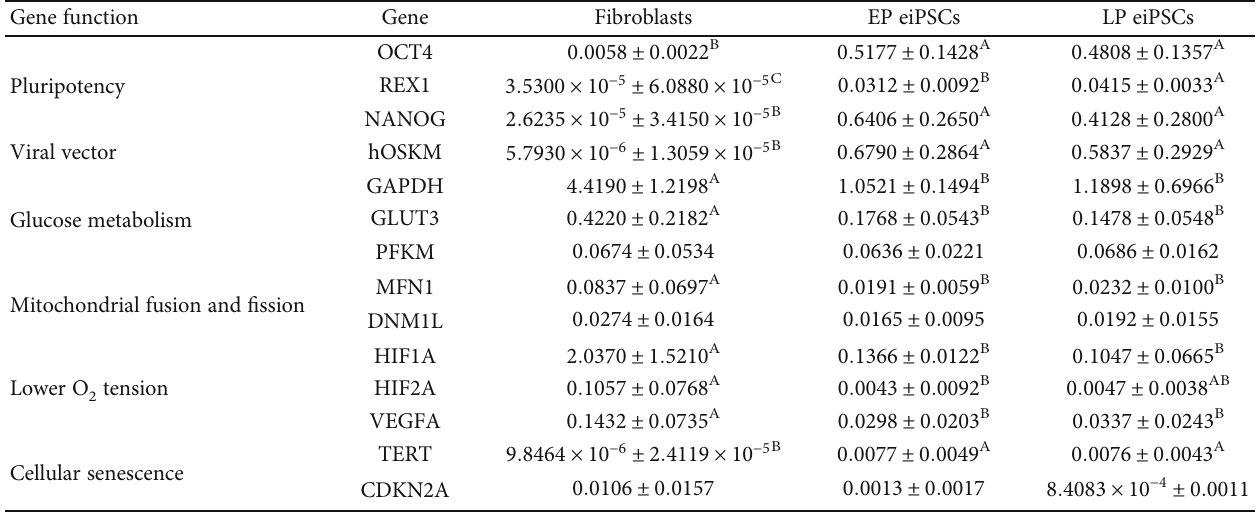
Table 3: Gene expression analysis comparing fi broblasts with eiPSCs in the early passage (EP eiPSCs — passage 5) and late passage (LP eiPSCs — passage